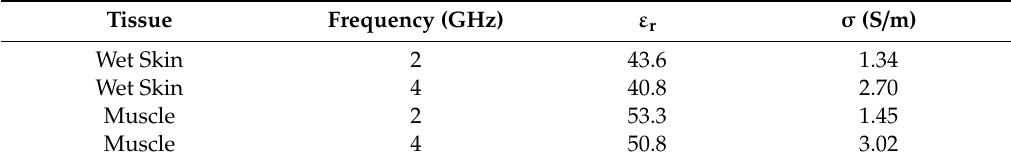
Table 2. Dielectric properties of the tissues [18].